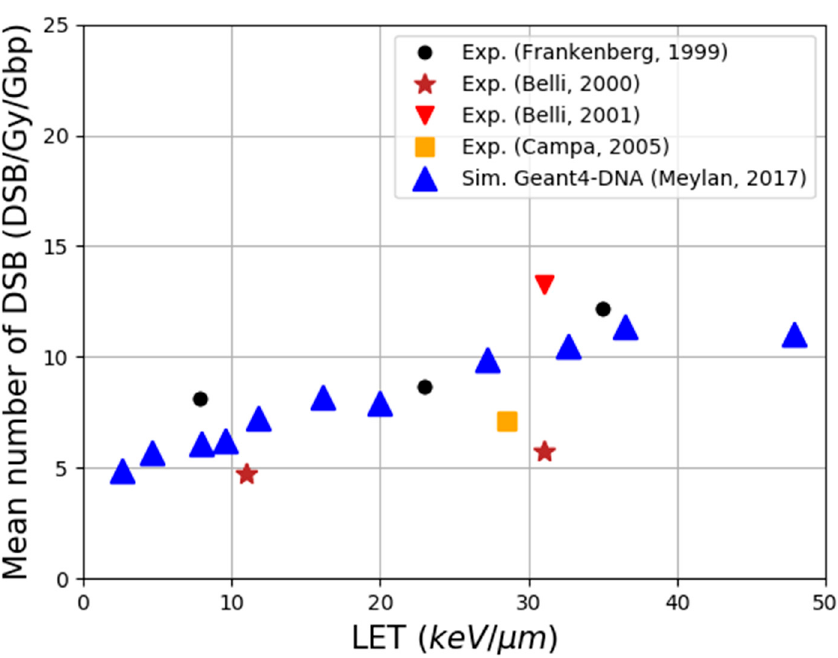
Figure 5. Comparison of DSB yields from the literature with those that were calculated with Geant4- DNA for protons of different LET, reproduced from [116].